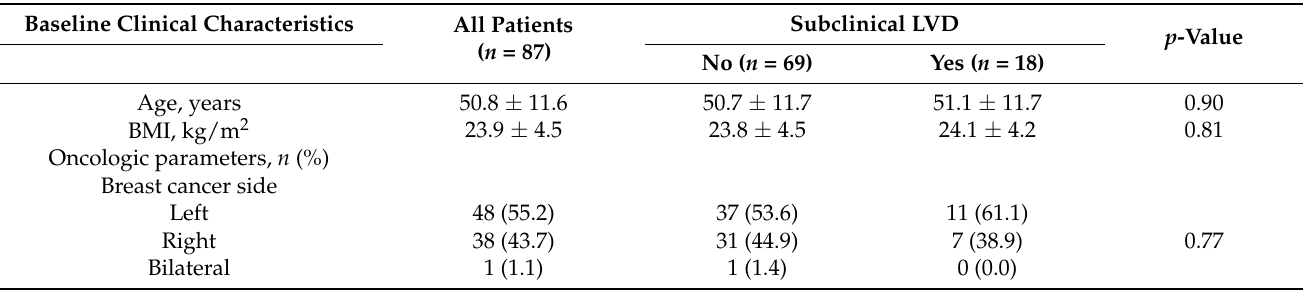
Table 1. Baseline clinical characteristics in all BC patients and in patients categorized according to the absence or presence of subclinical left ventricular dysfunction (LVD) at 3 months after completion of ACC therapy (CUN